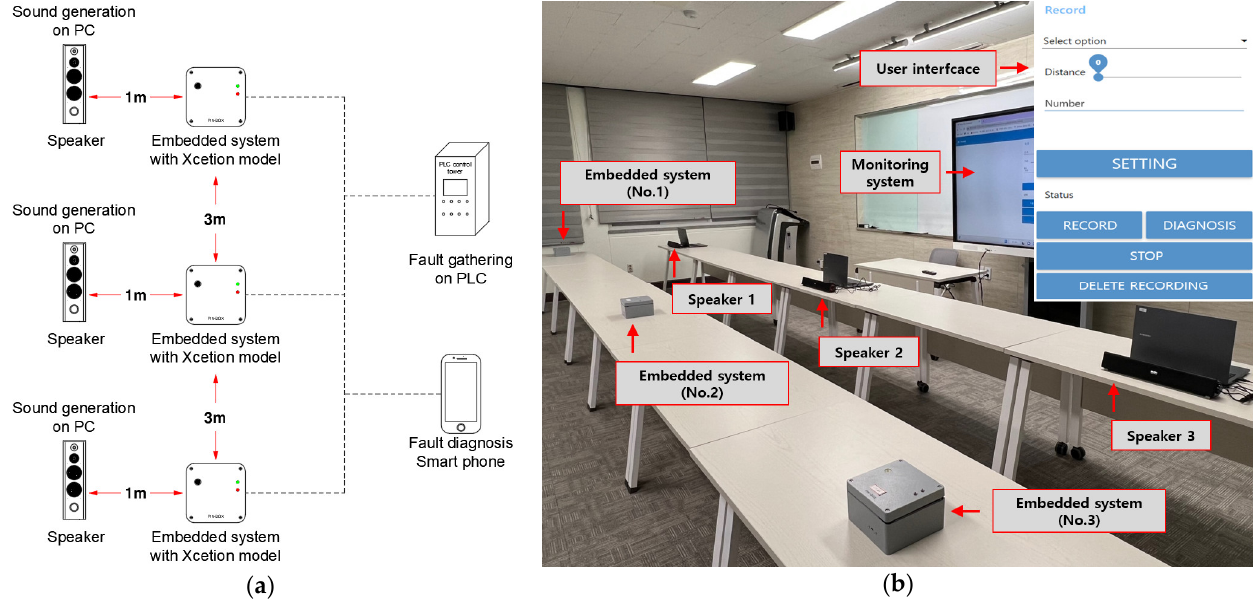
Figure 10. Embedded systems experimental environment as: ( a ) embedded system schematic; ( b ) embedded systems installed inside the laboratory.